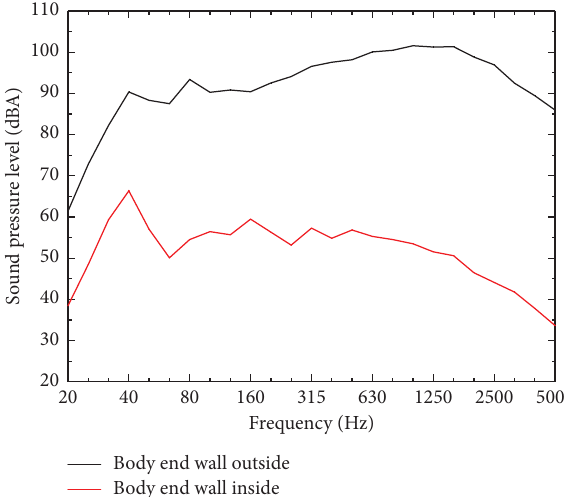
Figure 5: Spectrum diagram of noise measuring points inside and outside of the car body end